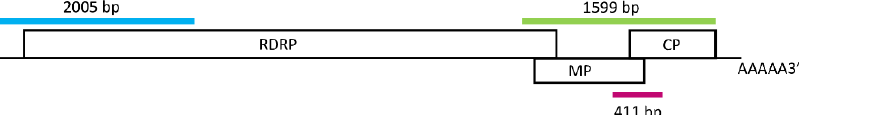
Figure 2. Schematic representation of cloned regions of GPGV, indicating size and position on GPGV genome; 411 bp amplicon was generated using primers described by Glasa et al. [2]. In some cases, we failed to amplify the targeted amplicon. In C. album, we could only amplify the 411 bp product, possibly because of the low virus titer in the plant. At Jaszszentlaszlo, we could amplify GPGV only by using cDNA prepared with oligodT pri- mer, even from grapevine, and we failed to amplify the 5 ′ part of the virus, suggesting its low titer in the plants at this site. We had the same difficulty with woody species at Mogyorod. Although we could amplify GPGV using random primer-produced cDNA, we could not amplify the 5 ′ part of the virus. Our attempt to detect the virus with Northern blot was successful in only two cases, the Rosa sample originating from Eger and the Rubus sample originating from Tokaj, suggesting a higher virus titer in these two cases (Figure 3).